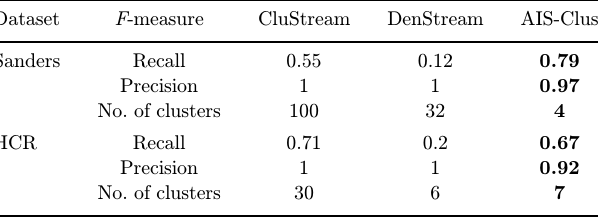
Table 6. Performance comparison of AIS-Clus with CluStream and DenStream.